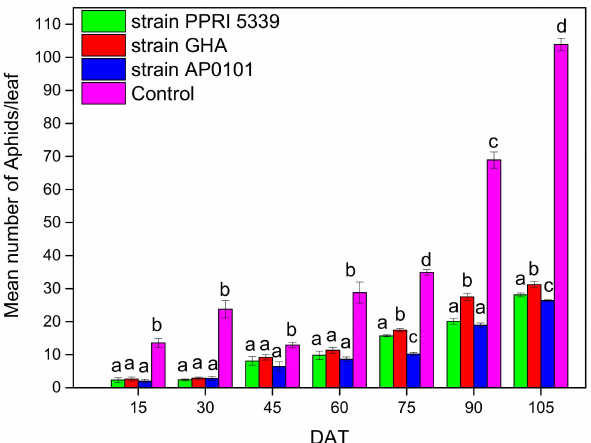
Figure 3. The average number of A. gossypii nymphs per leaf on C. melo plants inoculated with B. bassiana . Each treated plant was watered with 10 mL of 10 8 conidia/mL suspension at the stage of four leaves (May 2022), 25 leaves were sampled and examined from each treatment plot, only 3rd–4th instar nymphs were counted, means of the same DAT marked with the same letter did not differ significantly (Tukey-Kramer test, p < 0.05); DAT: days after